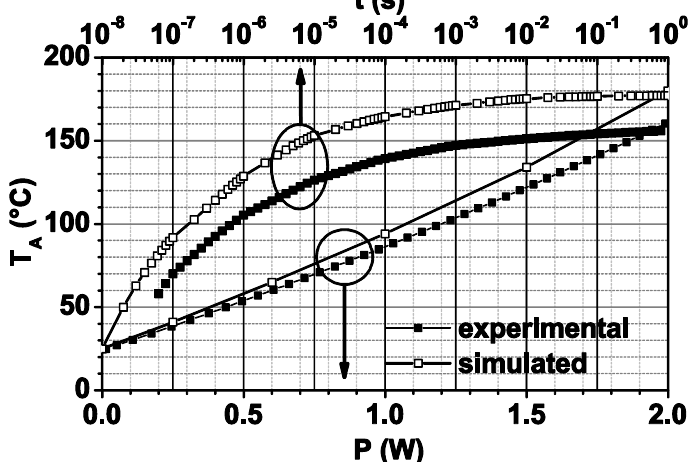
Figure 7. Average channel temperature T A vs. dissipated power P in quasi-static state and T A time dependence for applied V DS pulse.